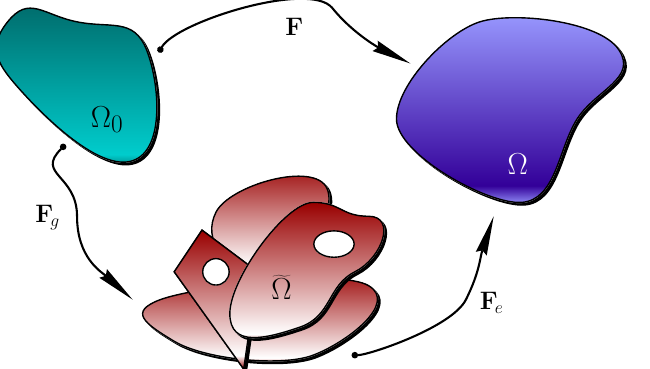
Figure 4. Decomposition of the tensor gradient of deformation F into pure growth F g and an elastic Ω , between the undeformed reference state deformation tensor F e . The intermediate configuration Ω Ω including growth and elastic response with stress, is an 0 and the current/final configuration (cid:101) incompatible and stress-free growth